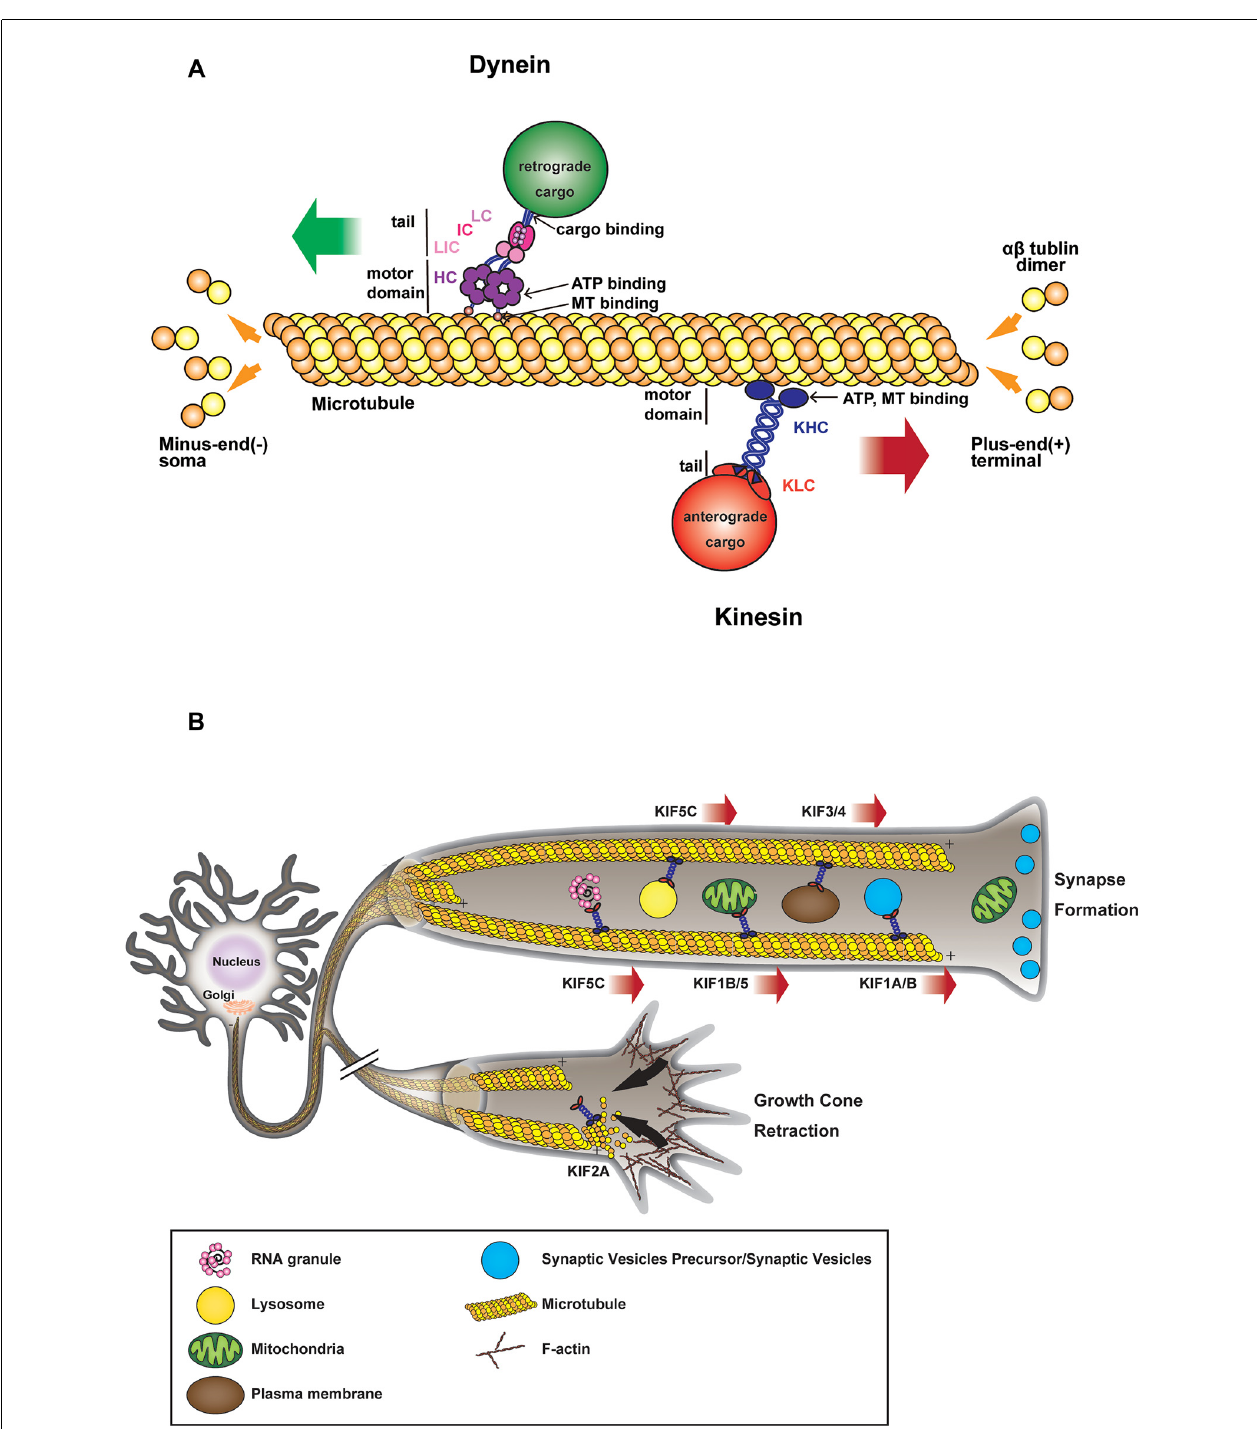
FIGURE 1 | (A) Microtubule (MT)-based transport machinery. Schematic representation showing how different molecular motors move along MTs toward MT plus-end (kinesins) or MT minus-end (dynein). Kinesins and dyneins motor domain bind to MT through their globular head domains which hydrolyze ATP during movement. Anterograde or retrograde cargoes bind to the tail domain of the motor either directly or through light/intermediate chains or adaptors. (B) Kinesin-mediated anterograde transport during axon elongation and synaptogenesis. Anterograde microtubule-dependent movements of membranous organelles and RNA granules are supported by various plus-end-directed kinesin motors. Organelles such as mitochondria, vesicles, RNA are transported from the soma toward axon tip during axonal growth and synapse formation. In the absence of motor activity, some kinesins also contribute to MT depolymerization during growth cone